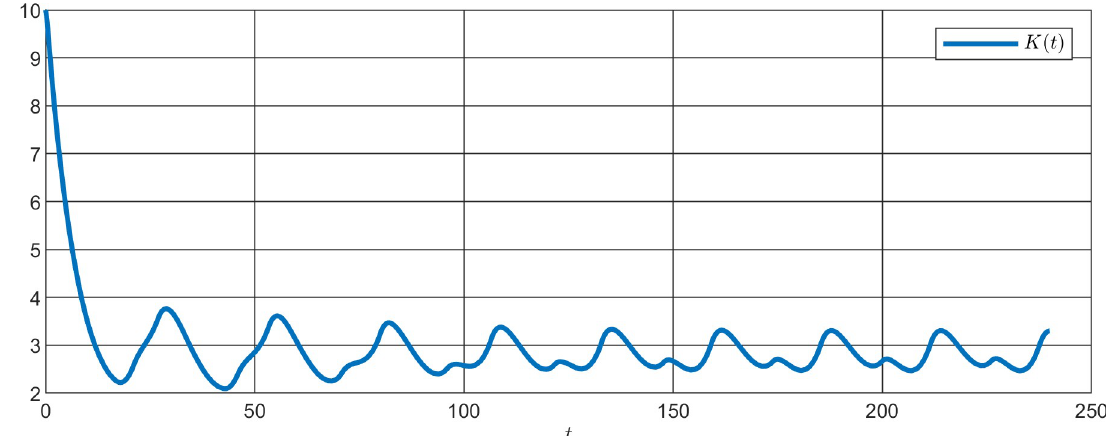
Fig 15. Simulation of K(t) for PER knockdown with a period of 25.96